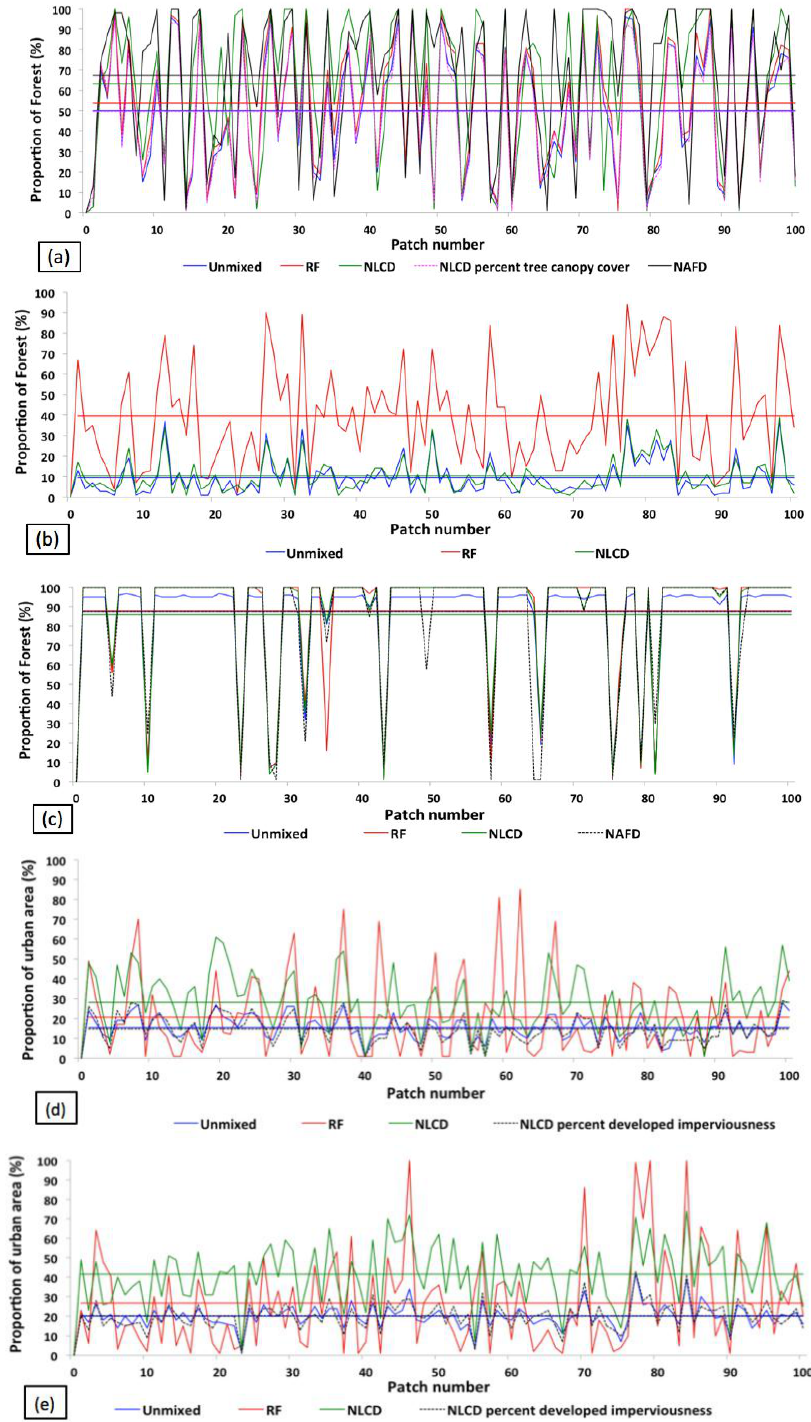
Figure 11. ( a ) Fraction of forest cover, ( b ) farmland, ( c ) water bodies, ( d ) urban built-up in the SF Bay Area and ( e ) LA area from unmixing, RF, NLCD and NAFD. The straight lines indicate the mean of the corresponding classes.